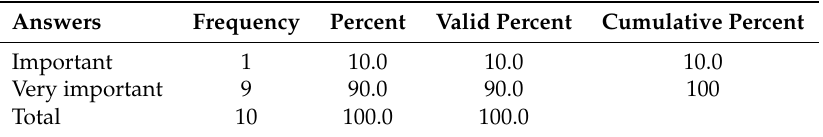
Table 7. Results of the answers of teachers to the question: Try to quantify on a scale of 1 (very little)